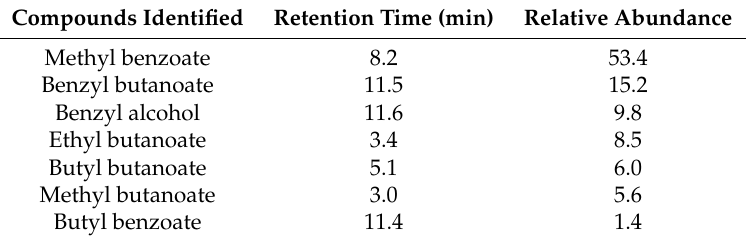
Figure 1. Chromatogram of essential oils extracted from mabolo fruit using Gas Chromatography-Mass Spectrometry. The peaks are labeled according to each compound identified. (1) Methyl butanoate, (2) Ethyl butanoate, (3) Butyl butanoate, (4) Methyl benzoate, (5) Butyl benzoate, (6) Benzyl butanoate, (7) Benzyl alcohol. Table 1. Isolated essential oil components by gas chromatography with their retention time (in min) and their percent abundance in the extracted